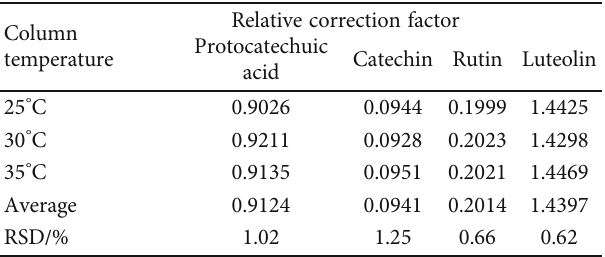
Table 6: E ff ects of di ff erent column temperatures on relative correction factors.